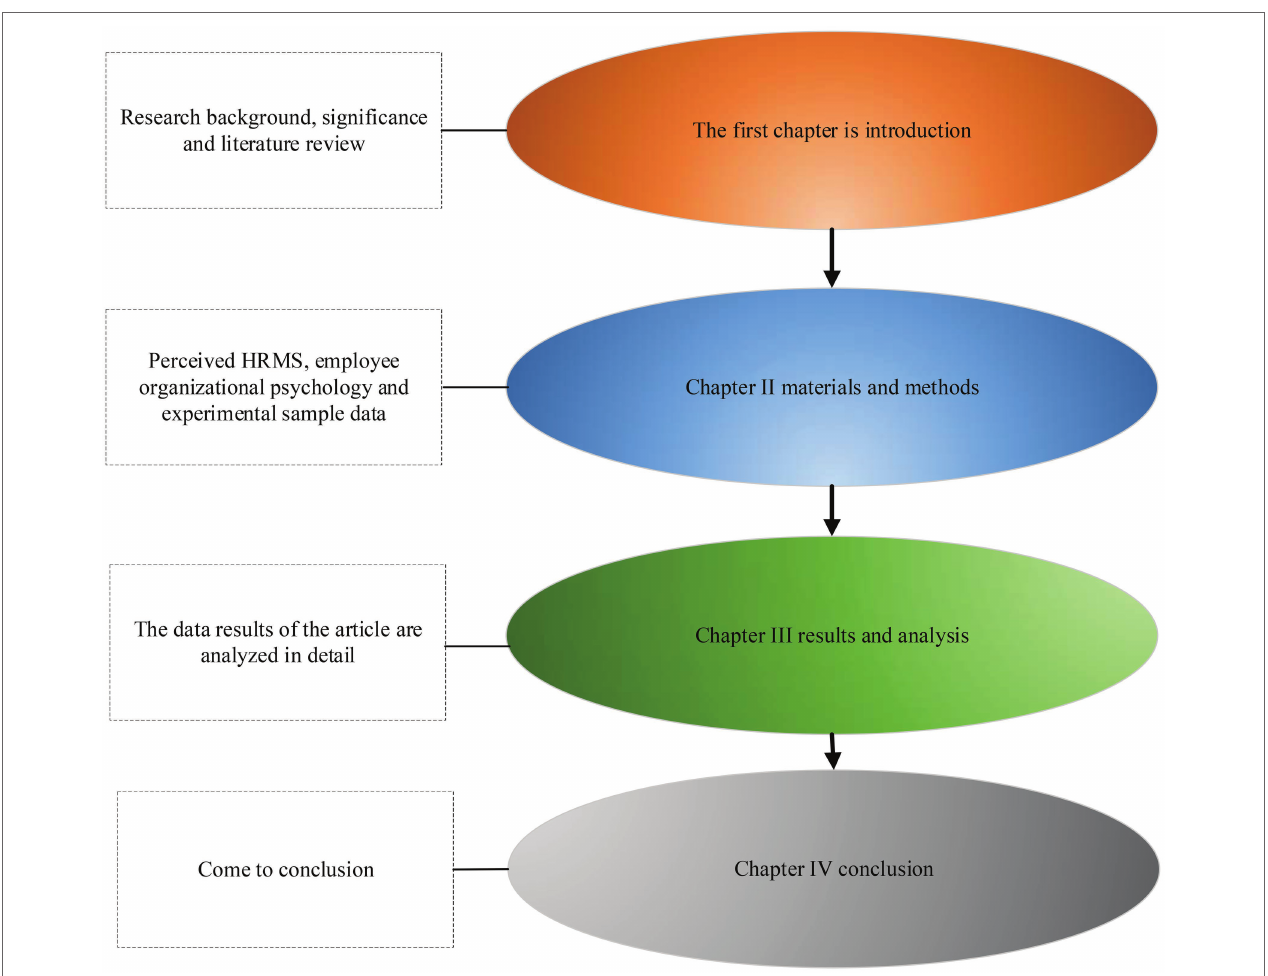
FIGURE 1 | Organizational structure of the